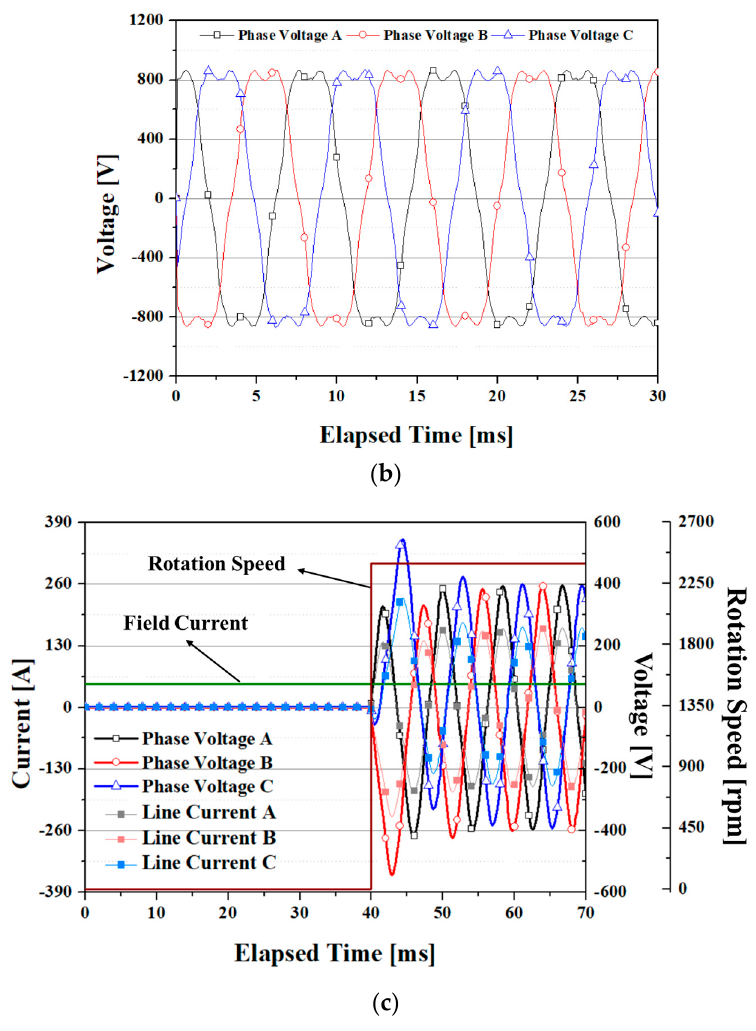
Figure 14. Steady-state operating characteristics of the HTS homopolar synchronous machine: ( a ) flux linkage, ( b ) no-load voltage, and ( c ) phase voltage and line current in resistive-load condition.